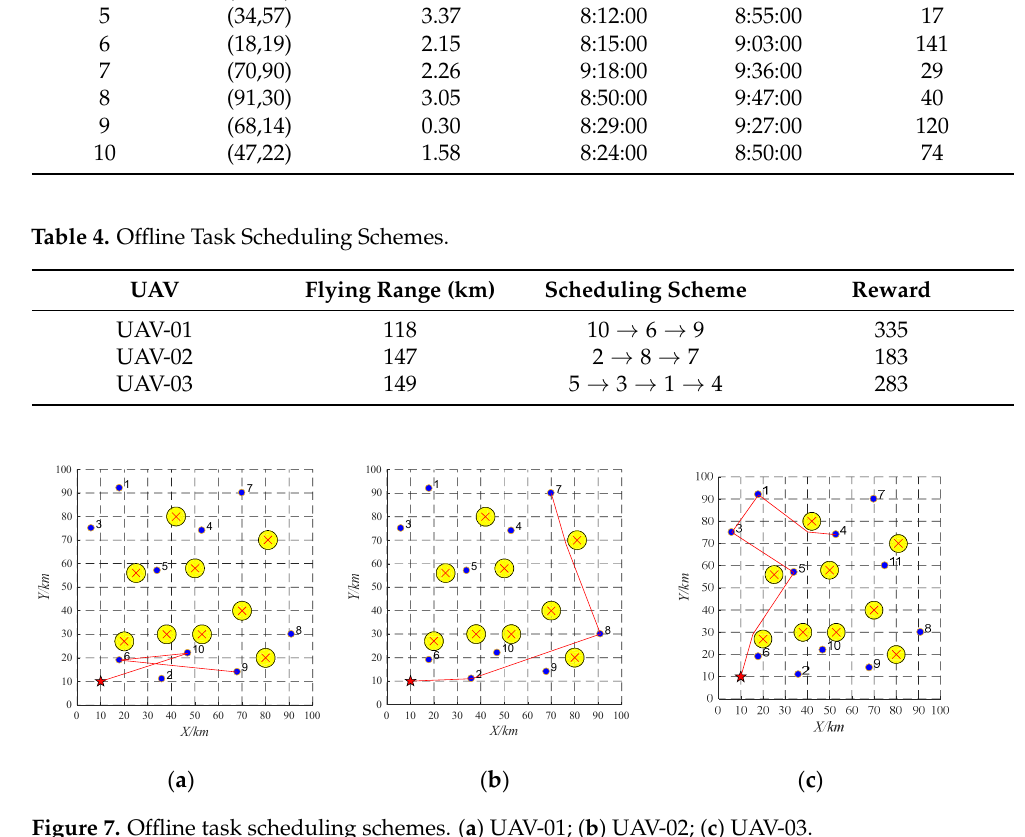
Figure 7. Offline task scheduling schemes. ( a ) UAV-01; ( b ) UAV-02; ( c ) UAV-03. Table 5. Parameter of the Emergency Tasks.